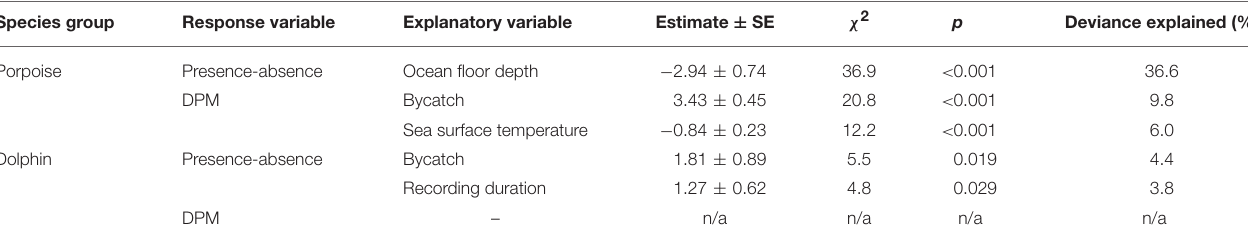
TABLE 2 | Explanatory variables retained in the minimum adequate hurdle models of Burmeister’s porpoise Phocoena spinipinnis and dolphin occurrence (presence-absence; binomial) and time spent (detection positive minutes, DPM; count).